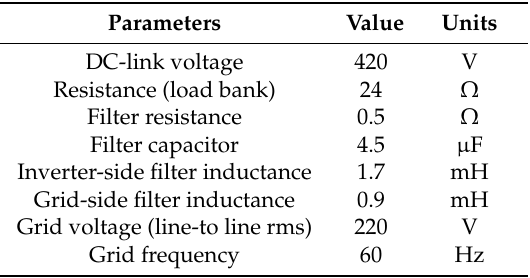
Table 1. System parameters of a grid-connected